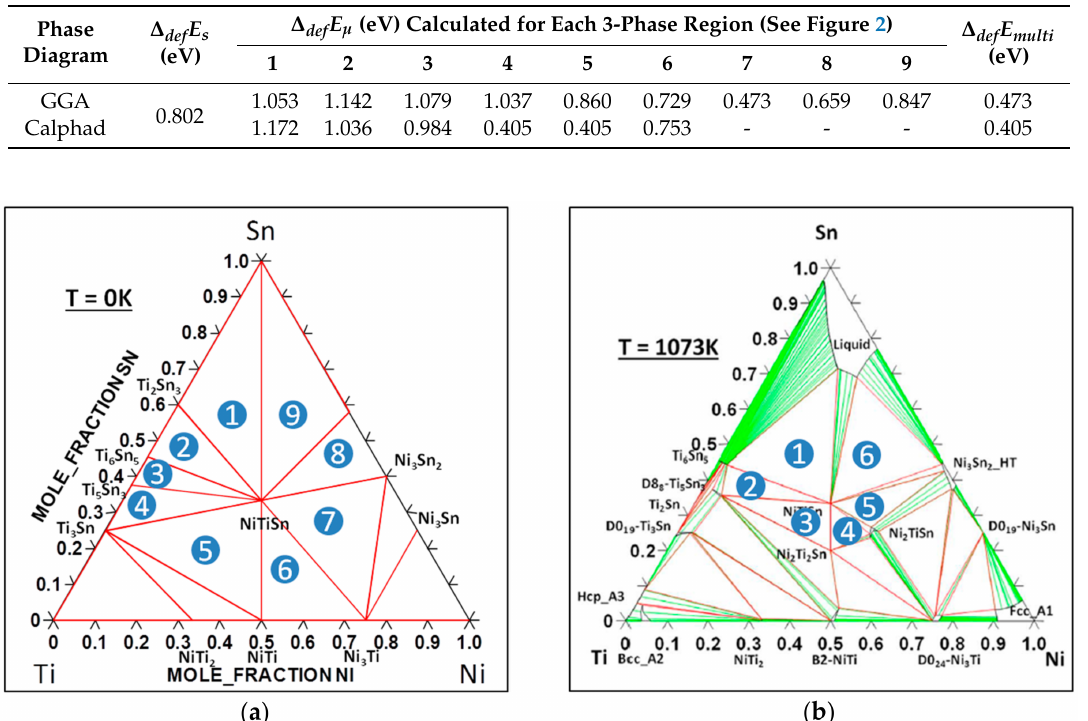
Figure 2. Isothermal phase diagram of the Ni-Sn-Ti system: ( a ) At 0 K, calculated in GGA; ( b ) at 1073 K plotted using the Calphad method